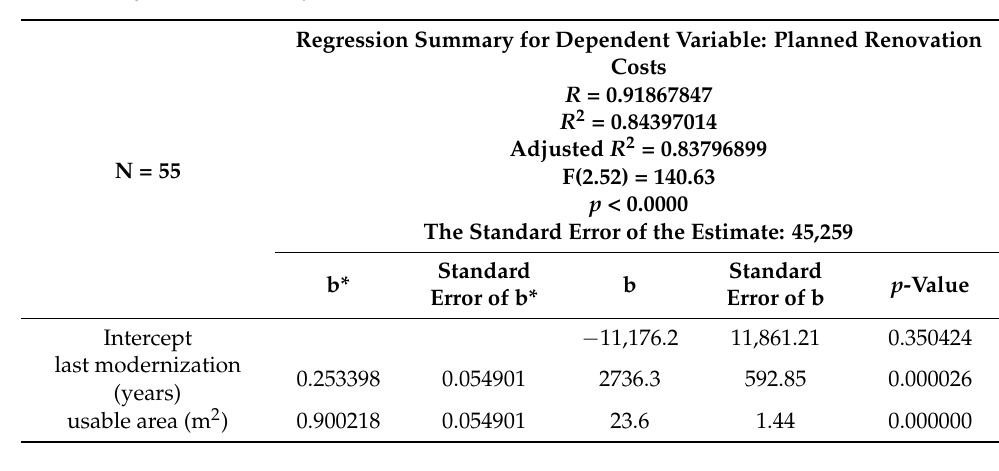
Table 4. Regression summary.